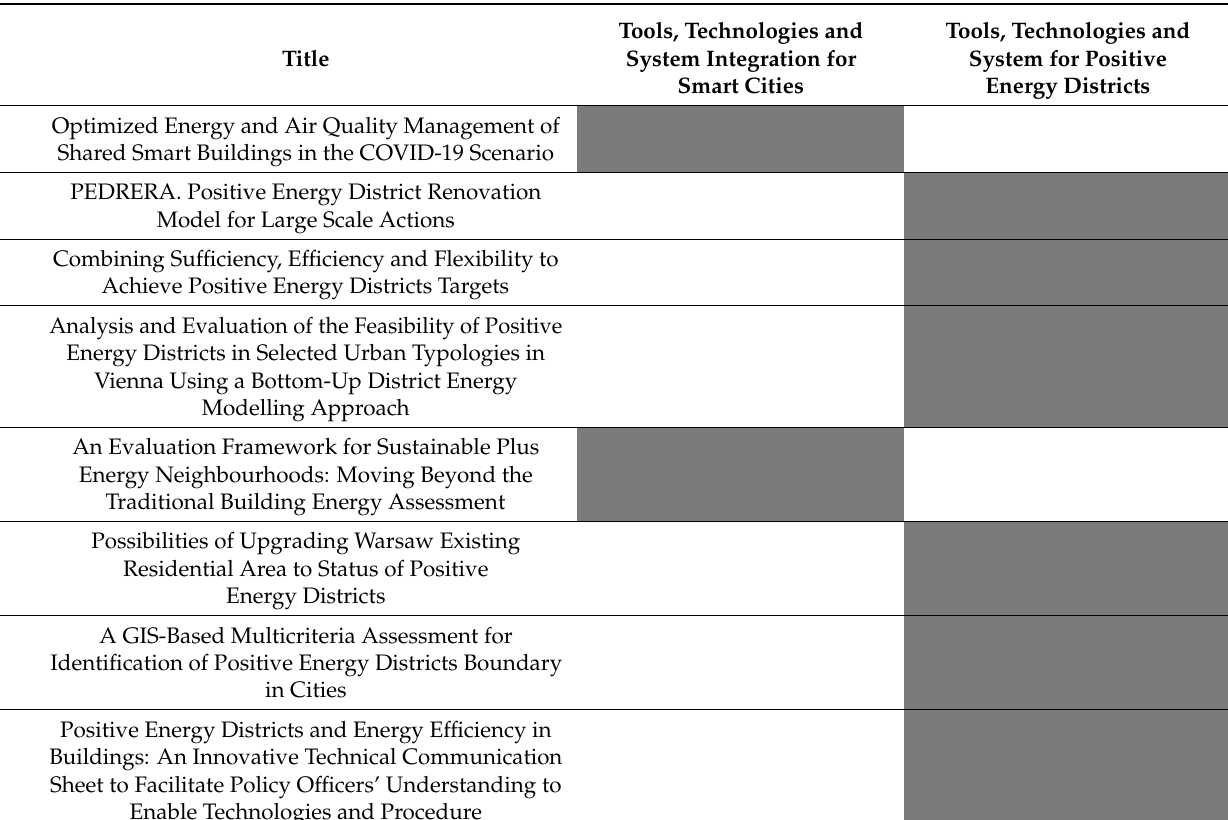
Table 1. Topics covered in each